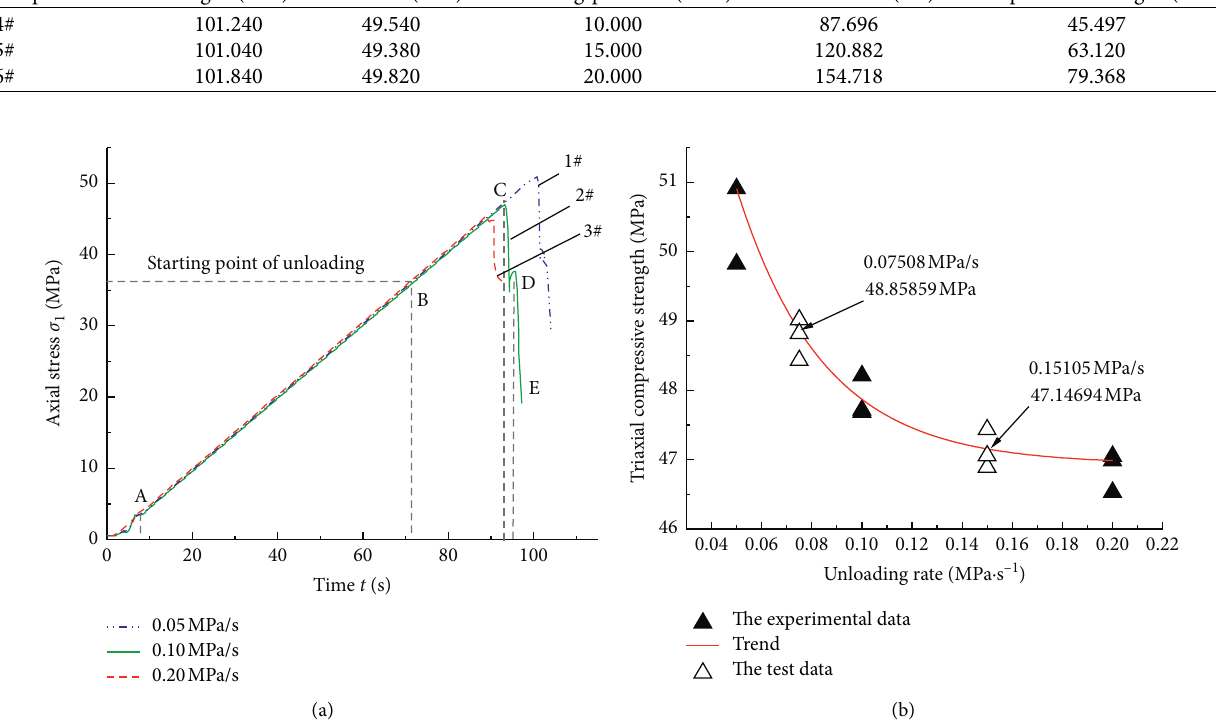
Figure 3: Stress path and compressive strength at different unloading rates. (a) Stress paths of 1# ∼ 3# samples. (b) Triaxial compressive strength fitting